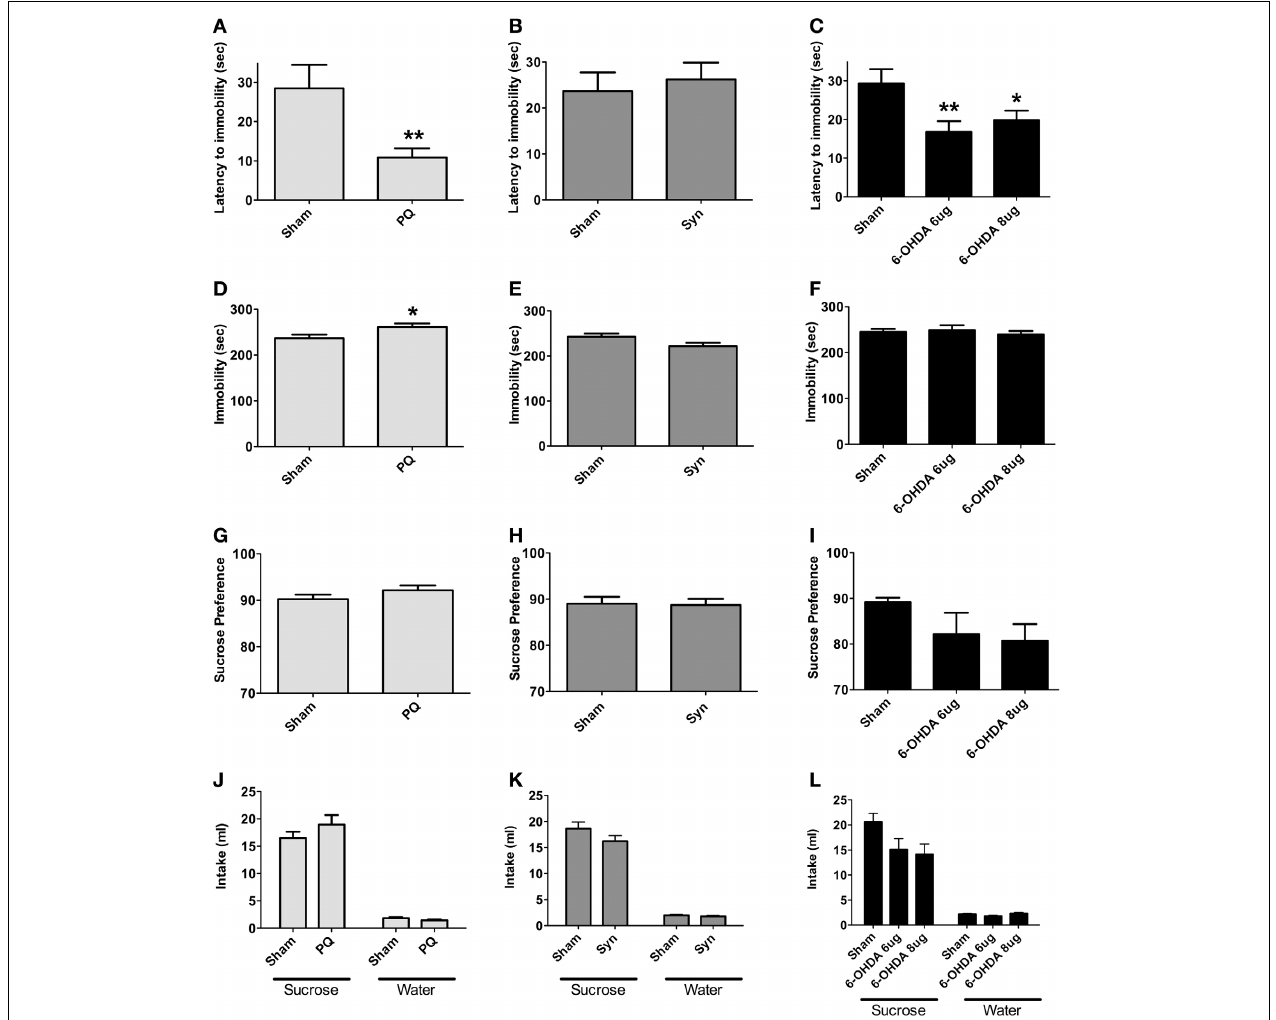
FIGURE 6 | Forced swimming test (A–F) for depressive-like behavior. Data regarding latency to immobility (A–C) and immobility time (D–F) . Presence of anhedonia, assessed through the sucrose preference test